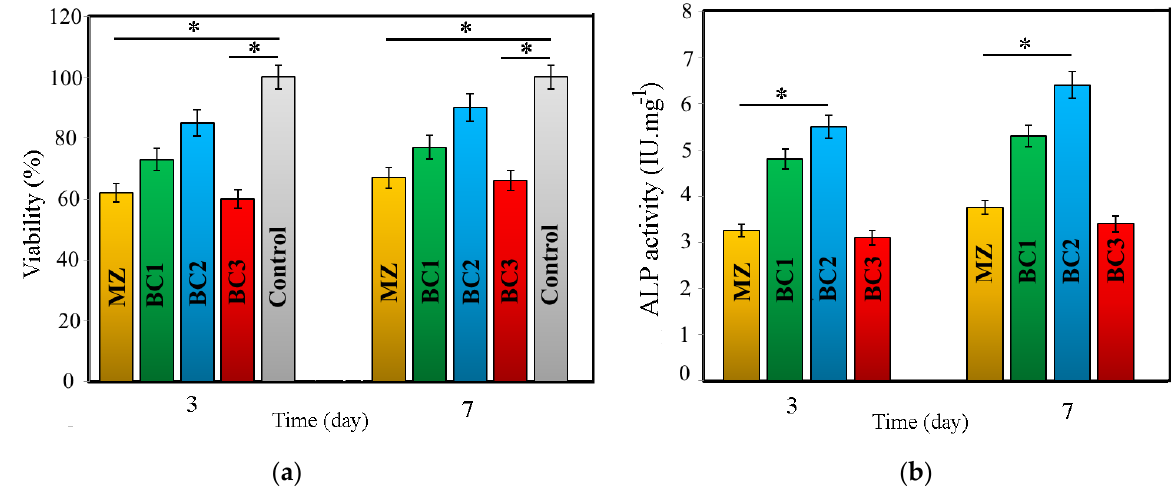
Figure 13. ( a ) Cell viability and ( b ) ALP activity for different composites (* p ≤ 0.05).